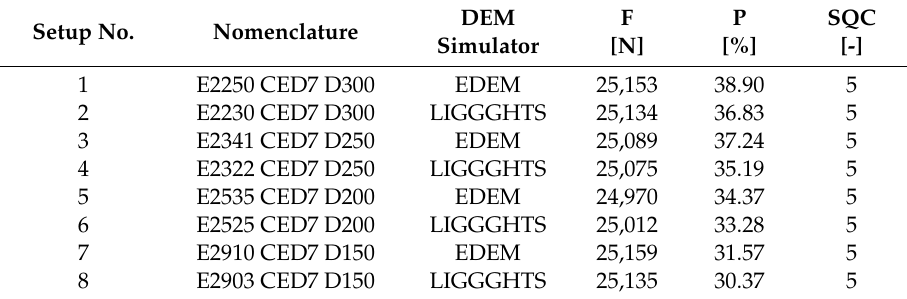
Table 8. Results obtained in the simulations used for the validation of the DEM models. Setup